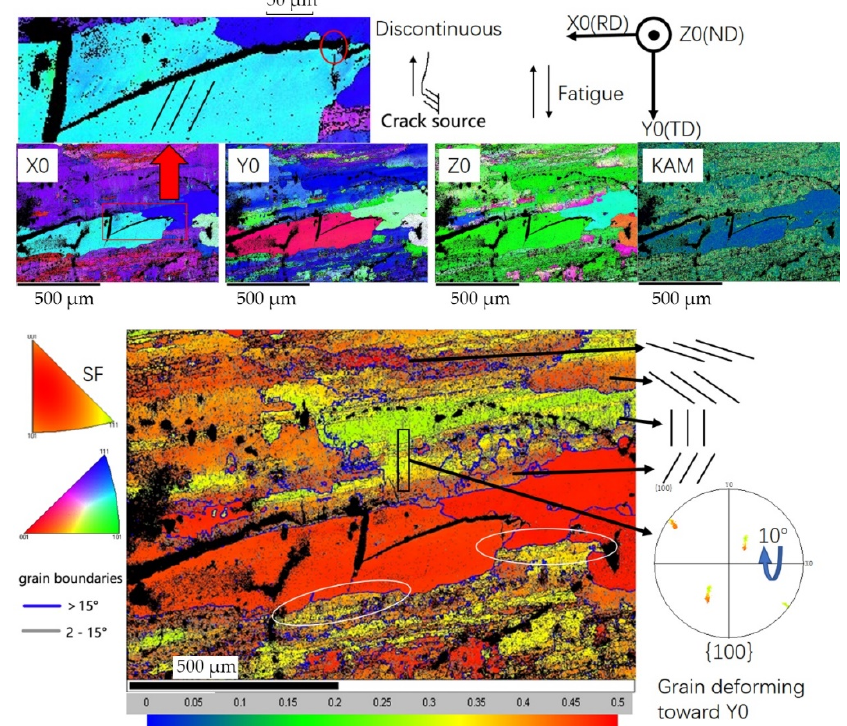
Figure 8. Maps of IPF-X0, IPF-Y0, IPF-Z0, KAM (local misorientation), and Schmidt factor near the crack in the base metal.